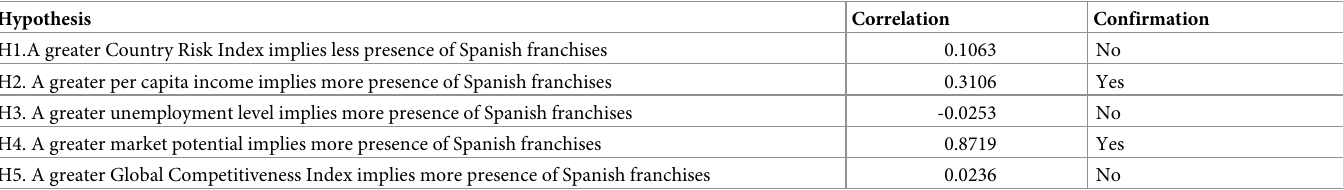
Table 9. Hypotheses proposed, correlation and confirmation.